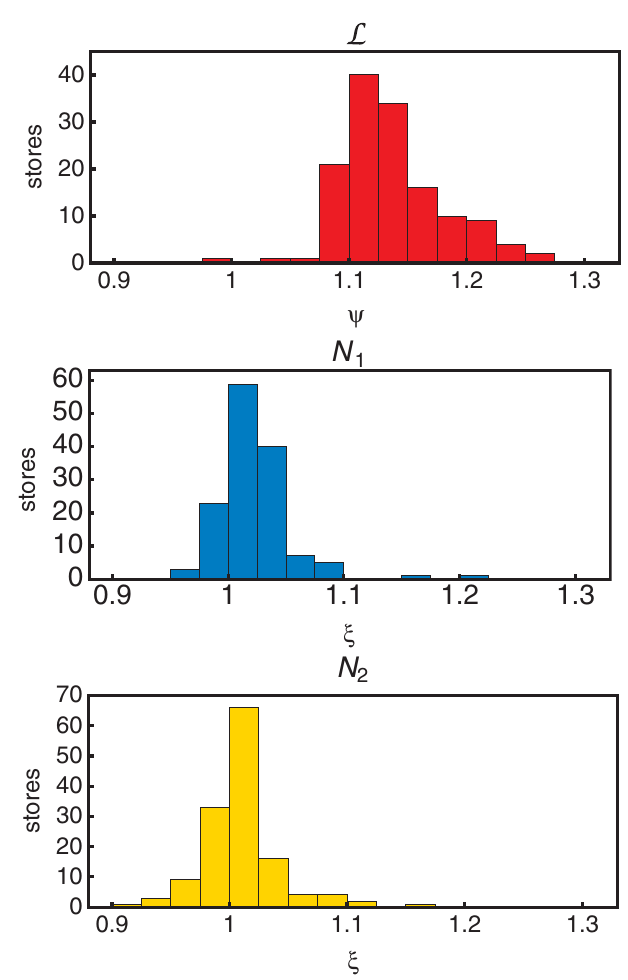
FIG. 9. (Color) Comparison of tracking simulation and measure- ment of integrated luminosity (top), instantaneous Blue (middle), and Yellow (bottom) bunch intensity for 139 stores in RHIC without stochastic cooling. The parameters (cid:14) and c are defined by Eq.